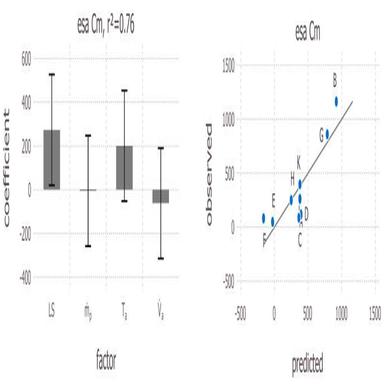
Coefficient and observed vs. predicted plots for the temperature profile smoothness.